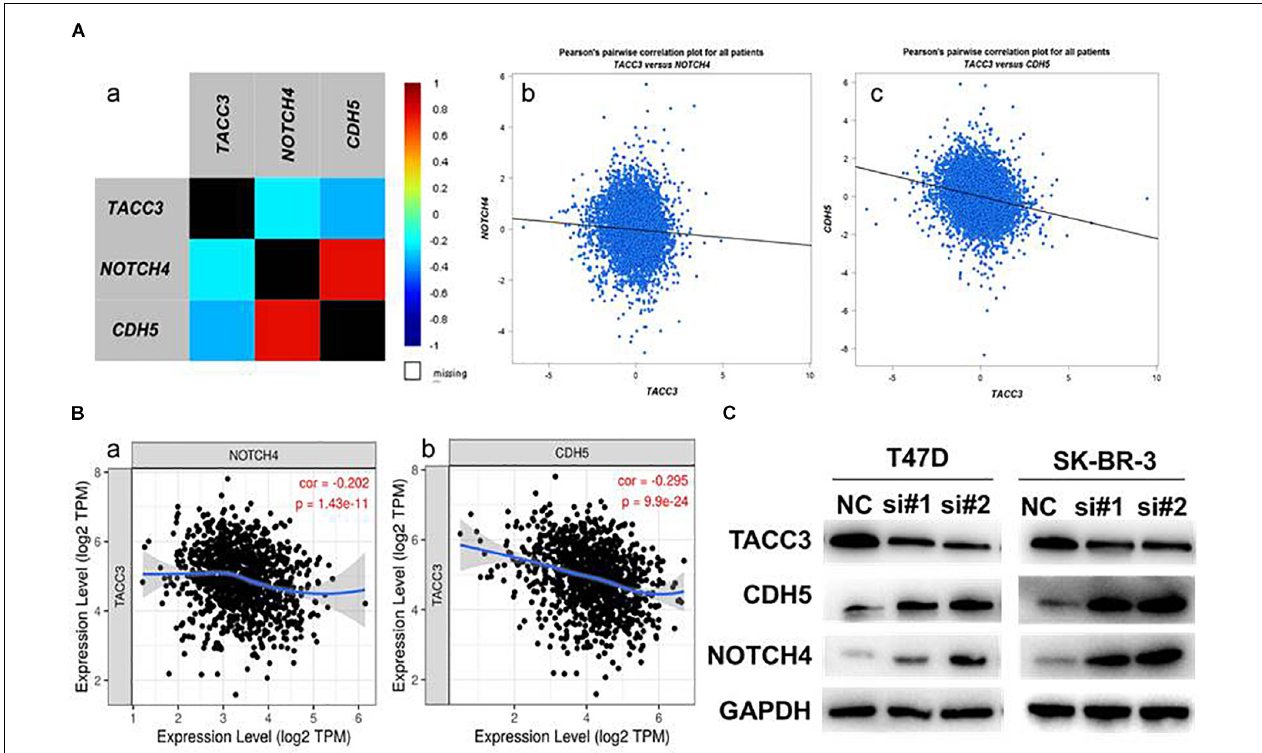
FIGURE 7 | The expression correlation between TACC3 and Notch4 and CDH5. (A) The correlation between TACC3 and Notch4 and CDH5 according to bc-GenExMiner v 4.4. (B) The correlation between TACC3 and Notch4 and CDH5 according to the TIMER database. (C) The Notch4 and CDH5 protein levels were evaluated by Western blot analysis in the siTACC3-treated cells. All assays were performed in biological